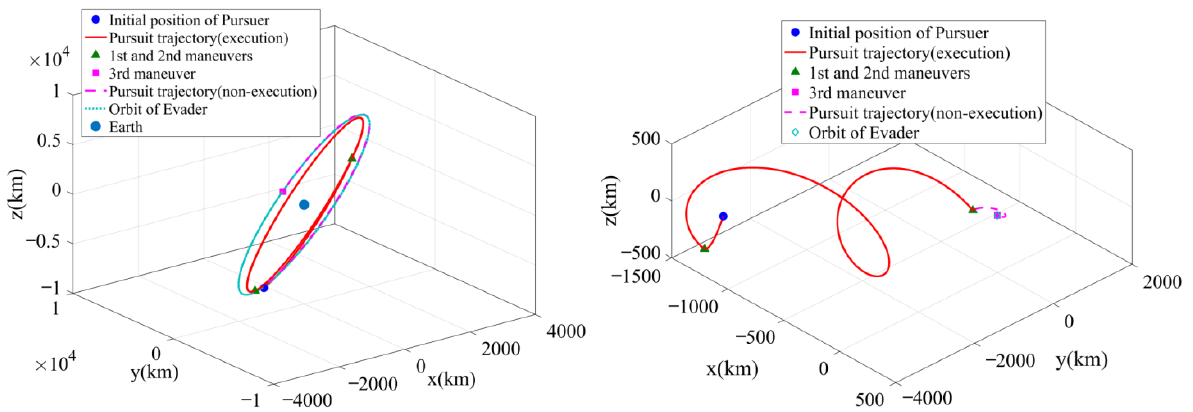
Figure 7. The pursuit trajectory of the FRS for case A ( left is the pursuit trajectory in J2000 Earth-centered inertial frame; right is the pursuit trajectory in the orbital coordinate system of the evader).